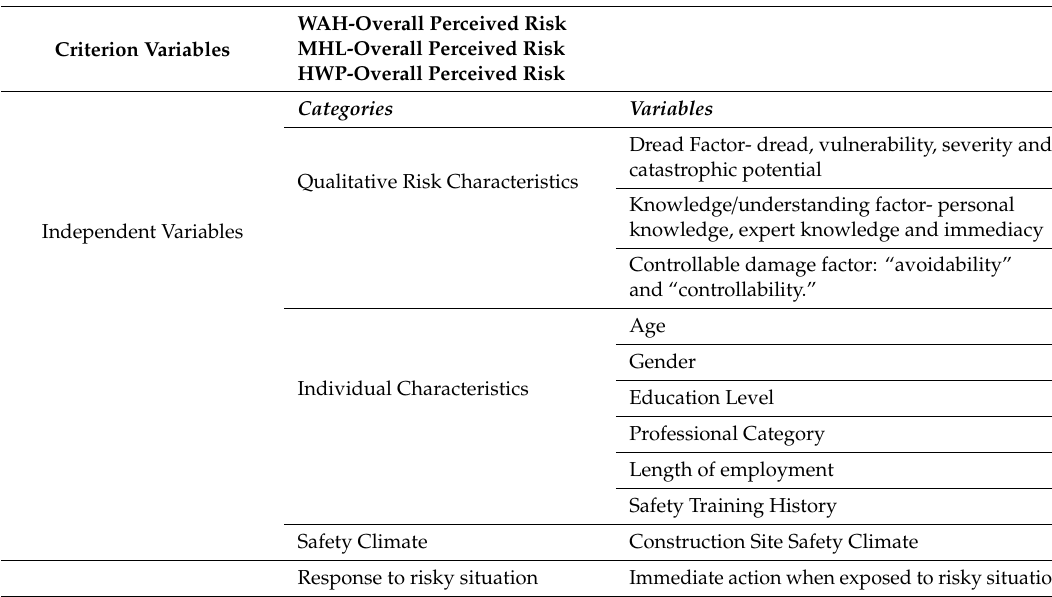
Table 1. An overview of the study